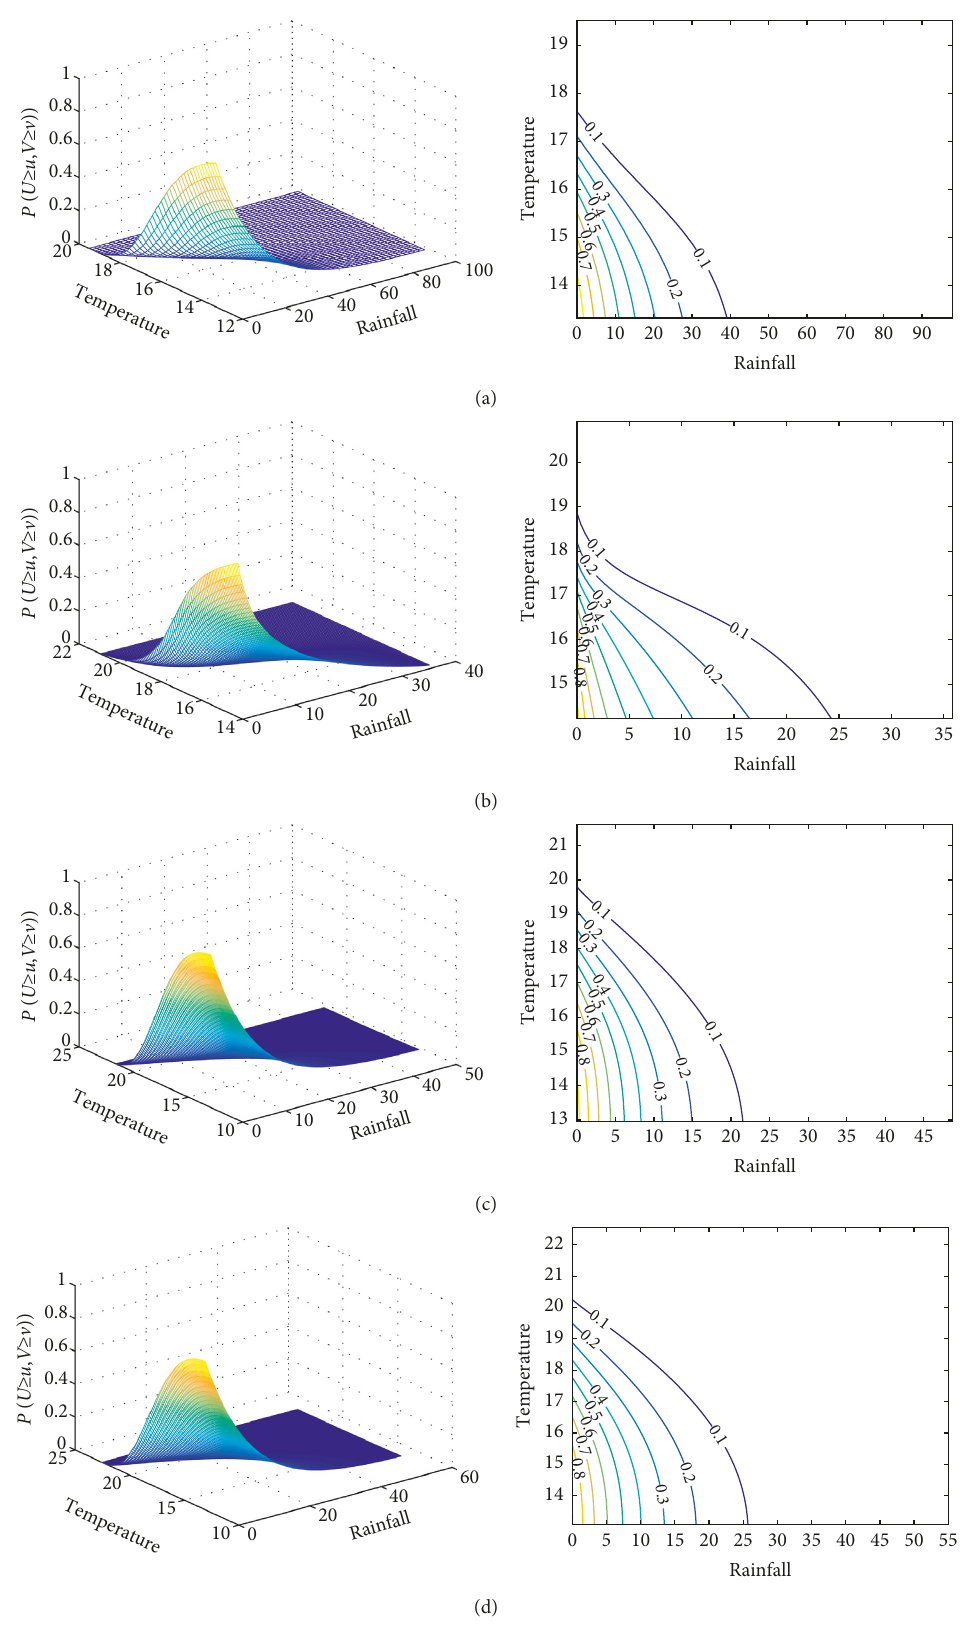
Figure 7: The joint probability Pr( U ≥ u , V ≥ v ) of precipitation and temperature for historical (a) and future (b) RCP2.6, (c) RCP4.5, and (d)